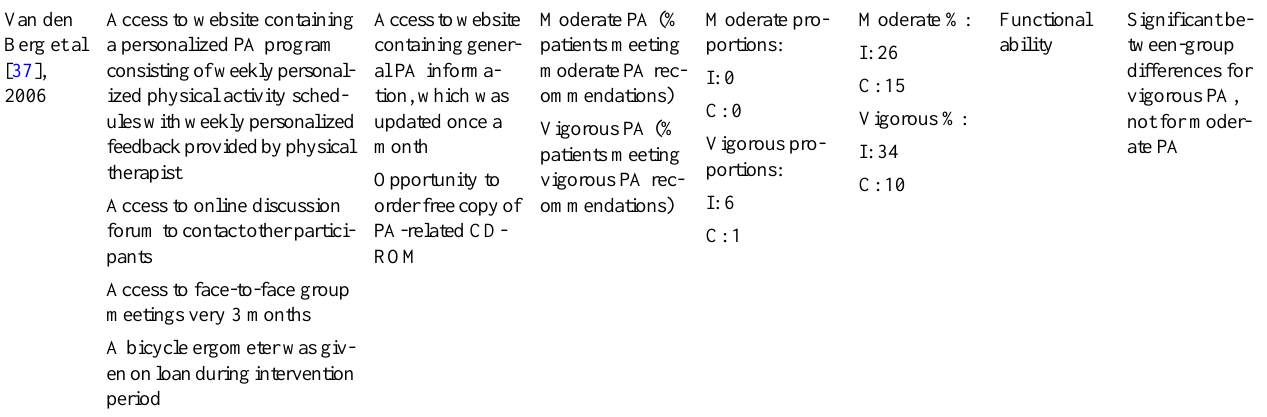
the participants and